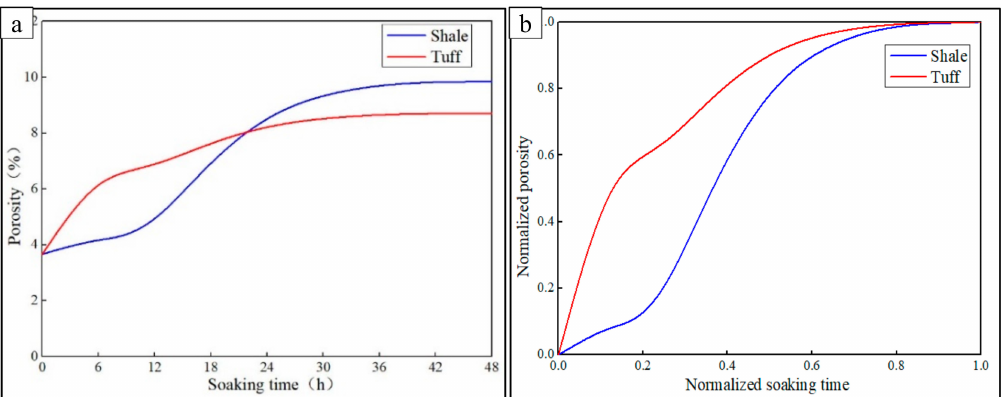
Figure 11. ( a ) the relationship between porosity and soaking time; ( b ) the relationship between normalized porosity and normalized soaking time.